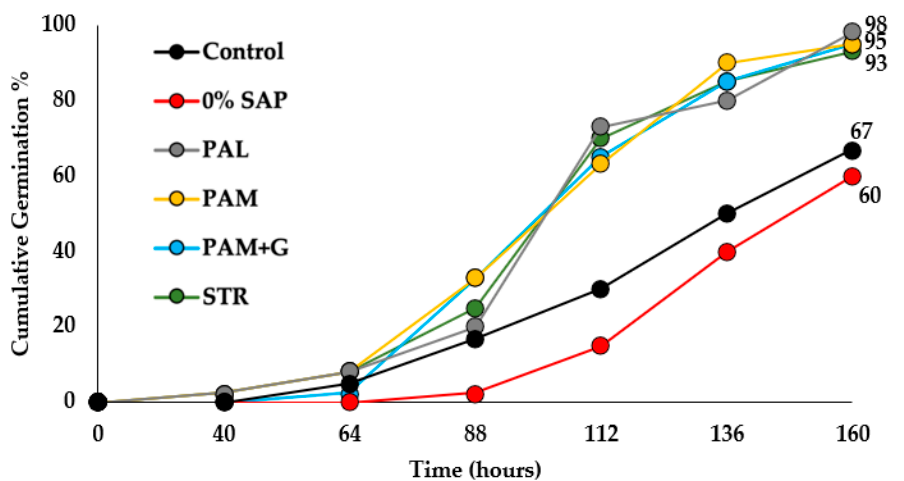
Figure 7. Cumulative germination % of 6 treatments of red clover seeds, broadcasted on montmorillonite clay at 20 °C.